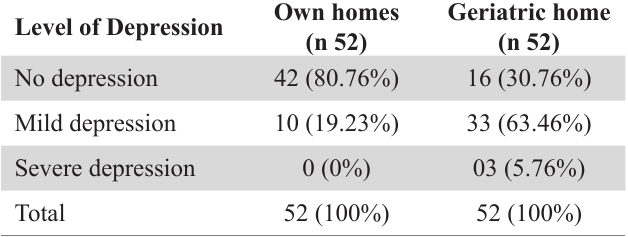
Table 2: Level of depression in elderly of geriatric home and those living in own